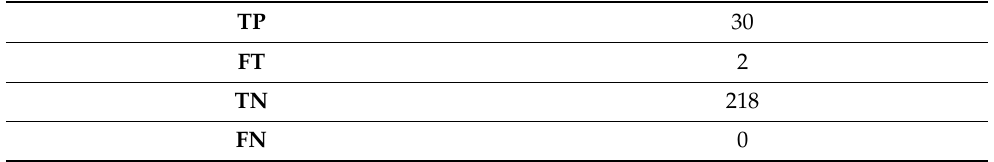
Table 11. The results of TP, FP, TN, and FN. TP 30 FT 2 TN 218 FN